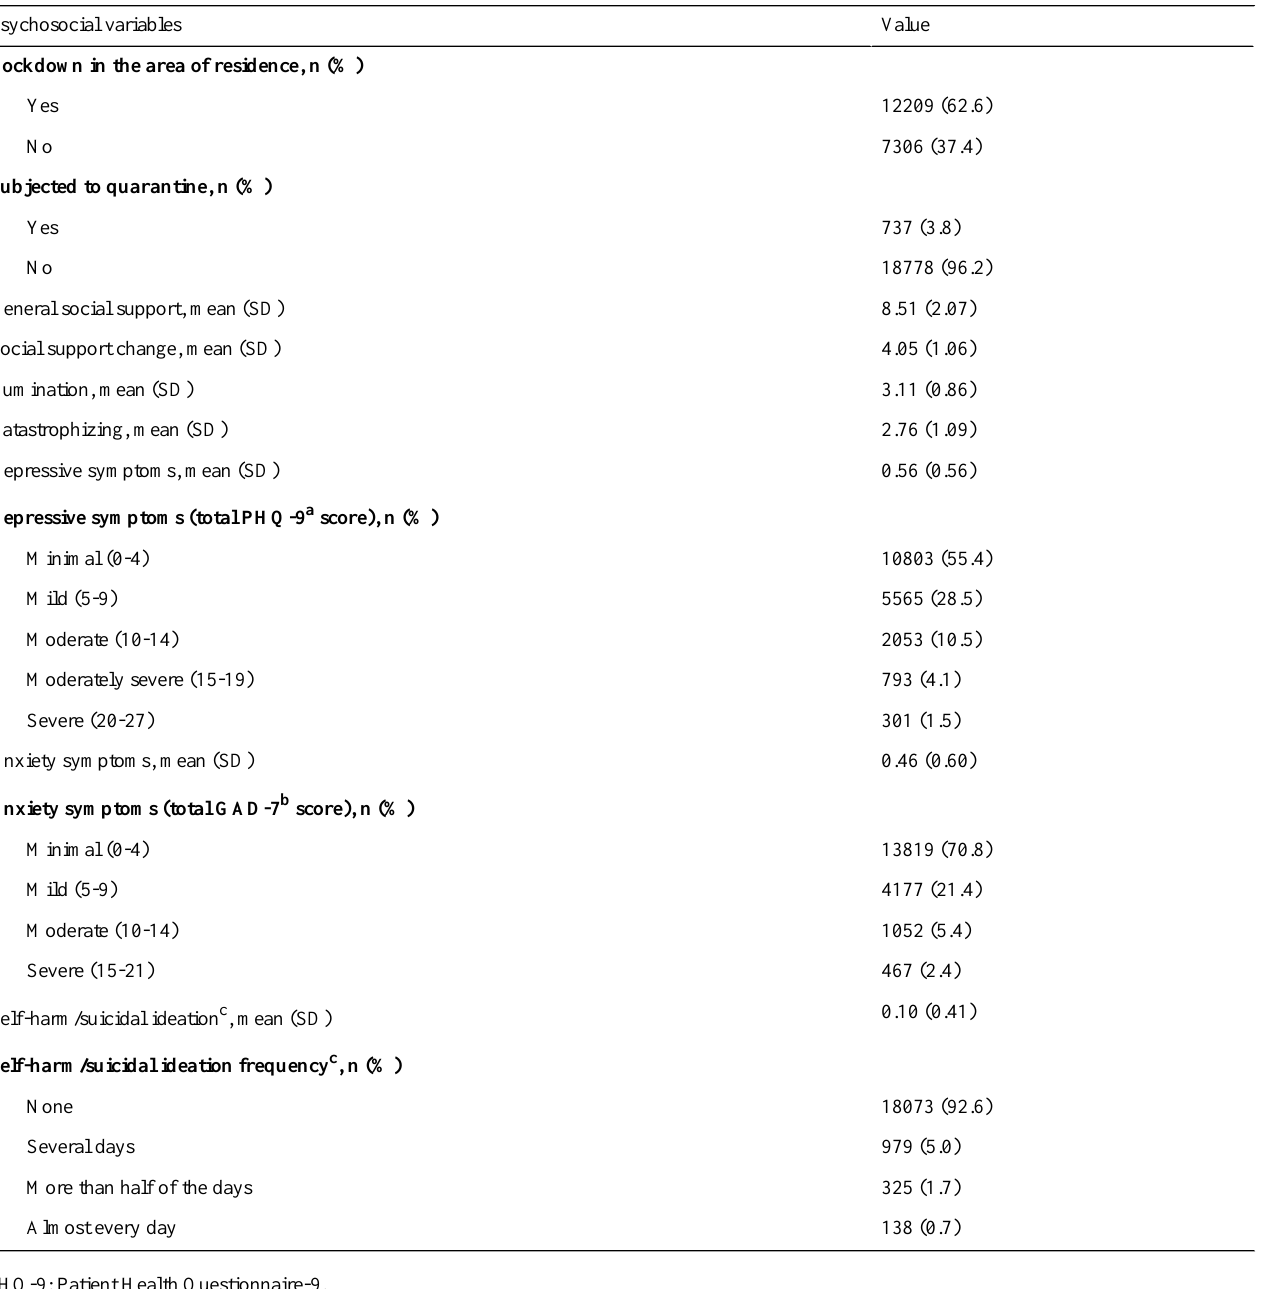
Table 3. Sociodemographic and maternal characteristics of the participants (N=19,515) based on psychosocial